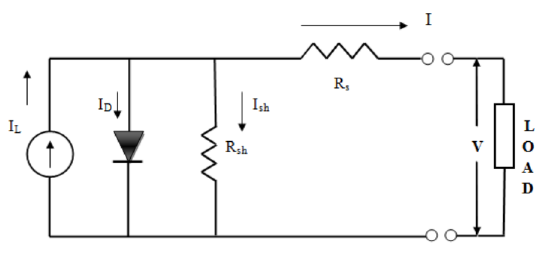
Figure 4. Equivalent circuit for an individual PV